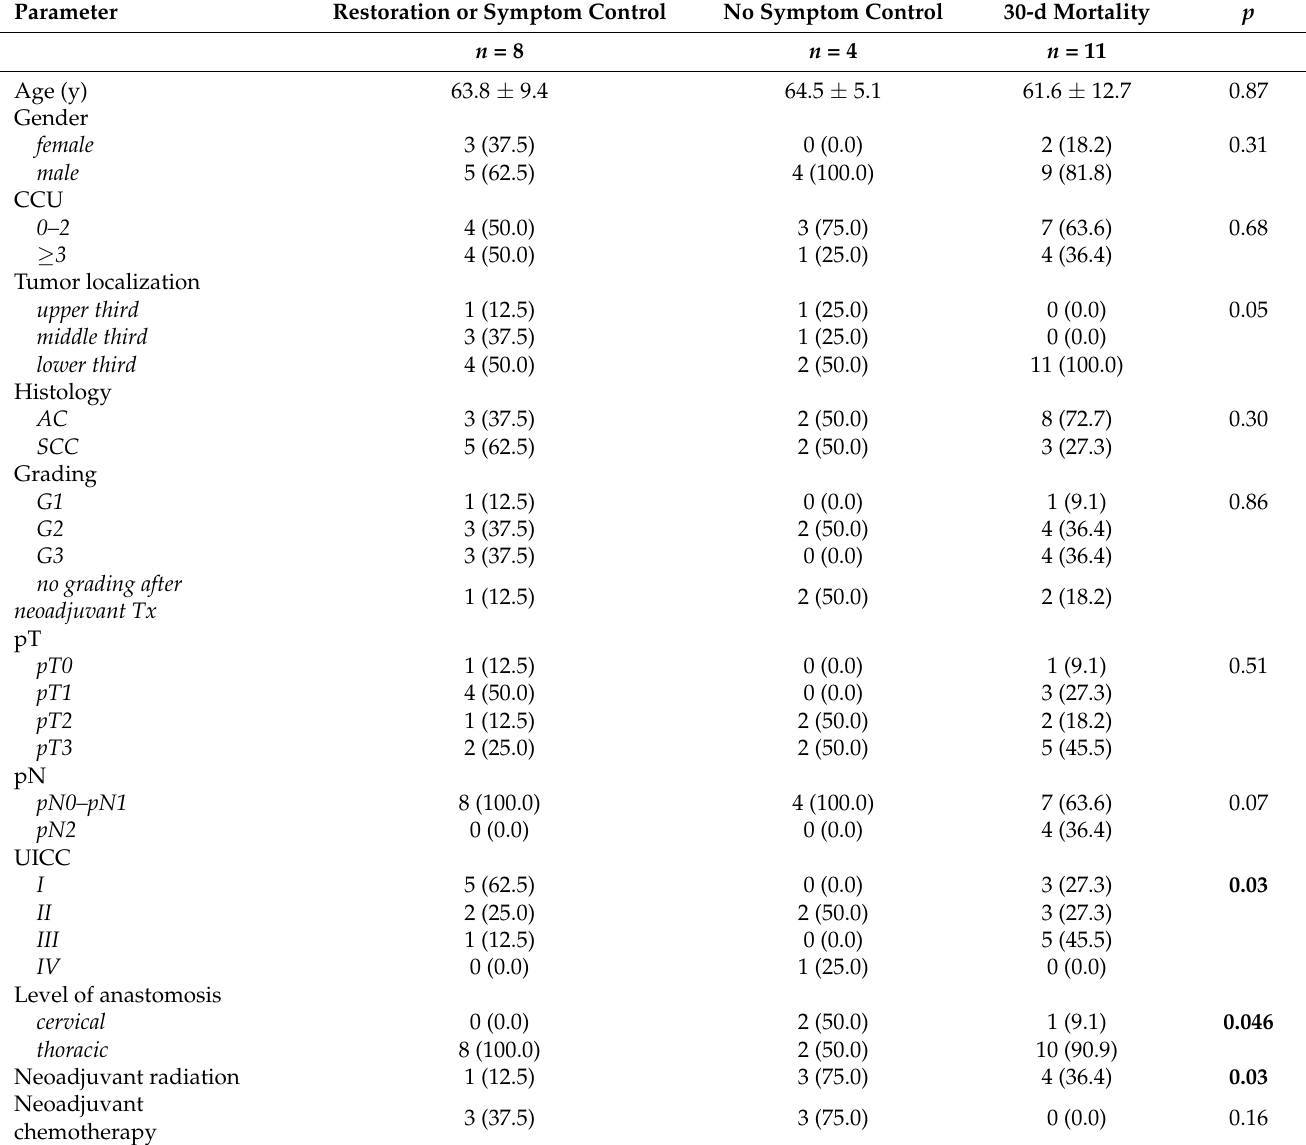
Table 3. Correlation of demographic, clinicopathological, and RDF parameters and risk factors with clinical outcome in S-RDF